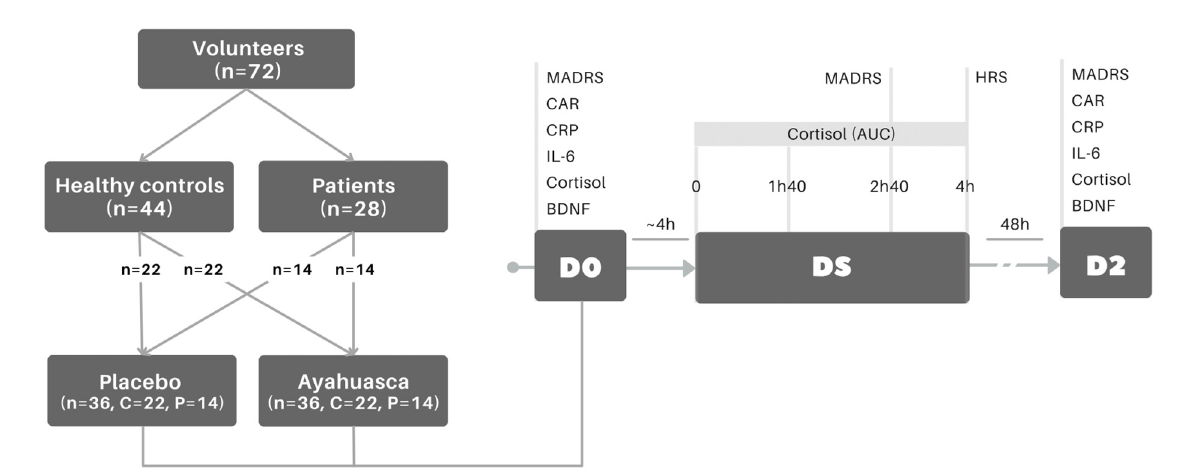
FIGURE1 Experimental design. Groups comprised treatment-resistant patients ( n = 28) and healthy controls ( n = 44). Each group had half of their participants allocated to a treatment: placebo ( n = 36, P: n = 14, C: n = 22) or ayahuasca ( n = 36, P: n = 14, C: n = 22). At baseline (D0), MADRS was assessed to quantify depressive symptoms, as well as blood and saliva samples were collected to measure biochemical markers. At the dosing session (DS), when the volunteer (patients or healthy control) takes ayahuasca or placebo, saliva samples were collected at times 0, 1 h40, 2 h40, and 4 h to determine AUC salivary cortisol and MADRS was assessed at 2 h40. After the dosing session (4 h), participants filled HRS to evaluate hallucinogenic experience. Two days after dosing session (D2 ∼ 48 h), MADRS, blood and saliva were collected again. MADRS, Montgomery–Åsberg Depression Rating Scale; CAR, salivary cortisol awakening response; CRP, plasma C-reactive protein; IL-6, serum interleukin 6; BDNF, serum brain-derived neurotrophic factor; HRS, hallucinogenic rating scale; AUC, area under the